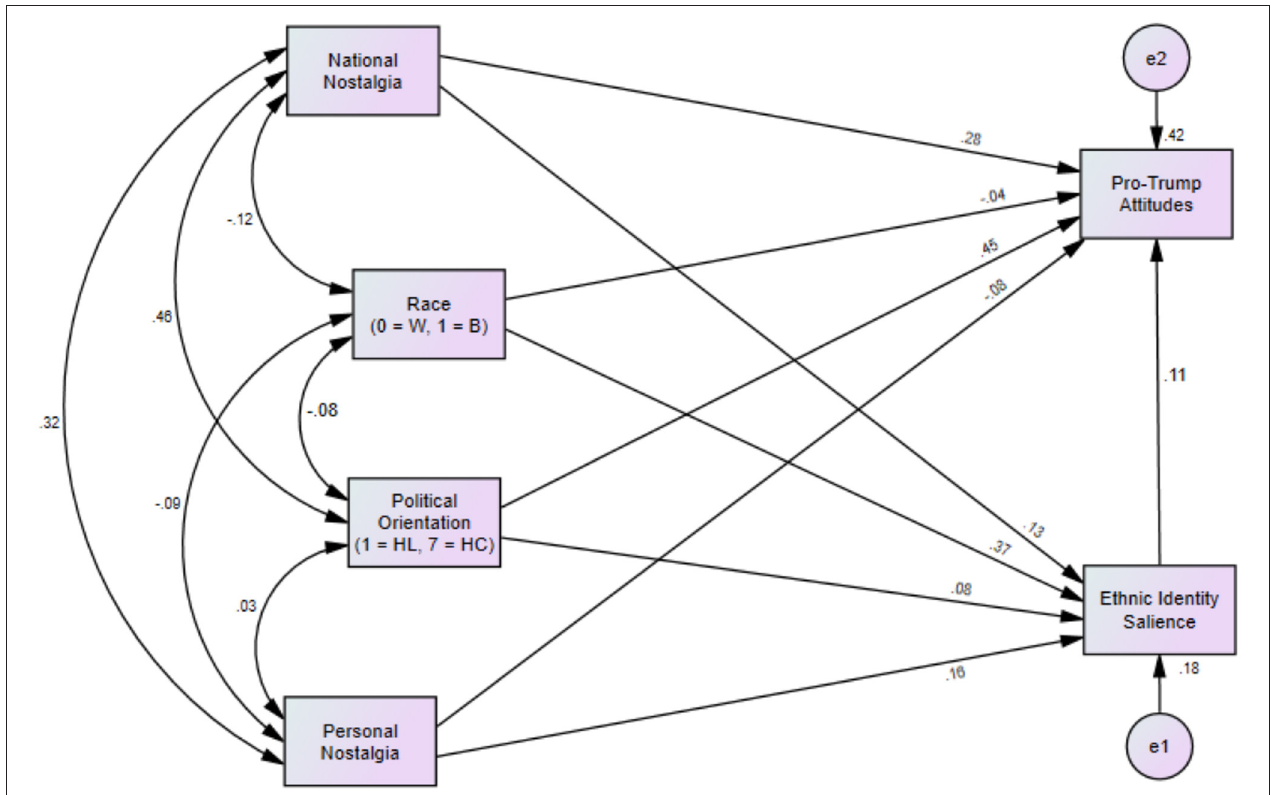
FIGURE 1 | Path analysis of relationships between national/personal nostalgia, ethnic identity, and pro-Trump attitudes (Model 1). Note. Path coefficients represent standardized estimates.